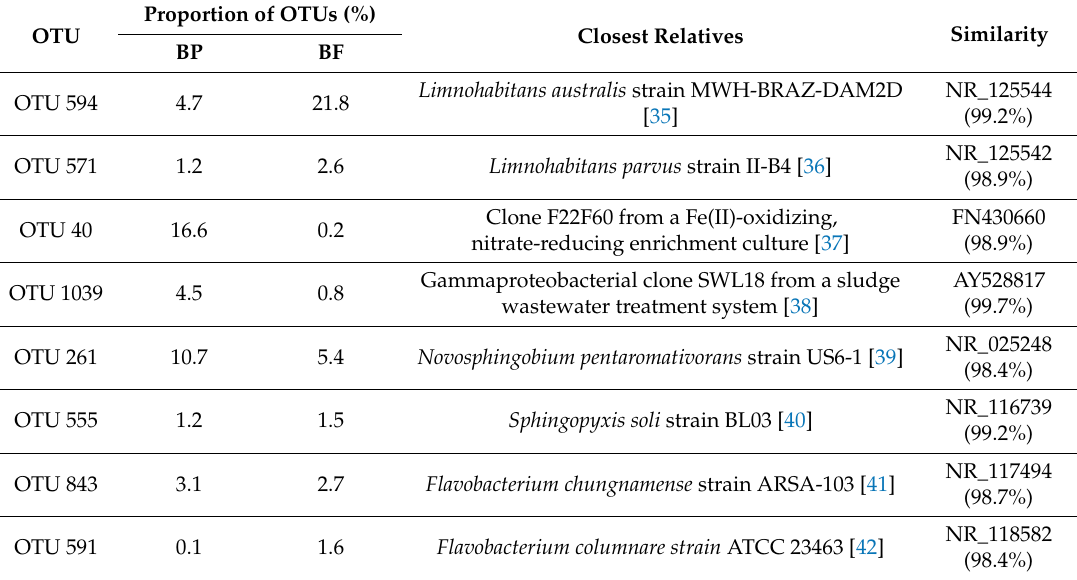
Table 3. Closest relatives of main OTUs in bacterial